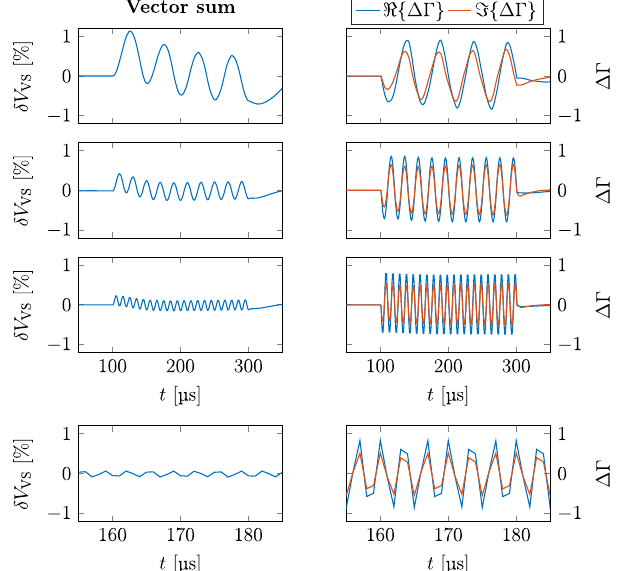
FIG. 14. Variation of the measured vector sum of the accel- erating gradient δ V (left) and the computed parameter Δ Γ VS (right) at ACC6 at FLASH while applying modulations with different frequencies on the forward power (from top to bottom: 20, 50, 100, and 300 kHz). The rf sampling time is 1 μ s.